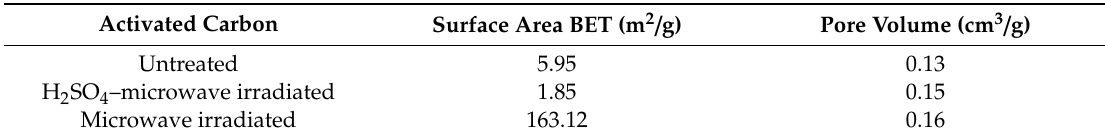
BET analysis of untreated, H 2 SO 4 –microwave-irradiated, and microwave-irradiated POMB-retained